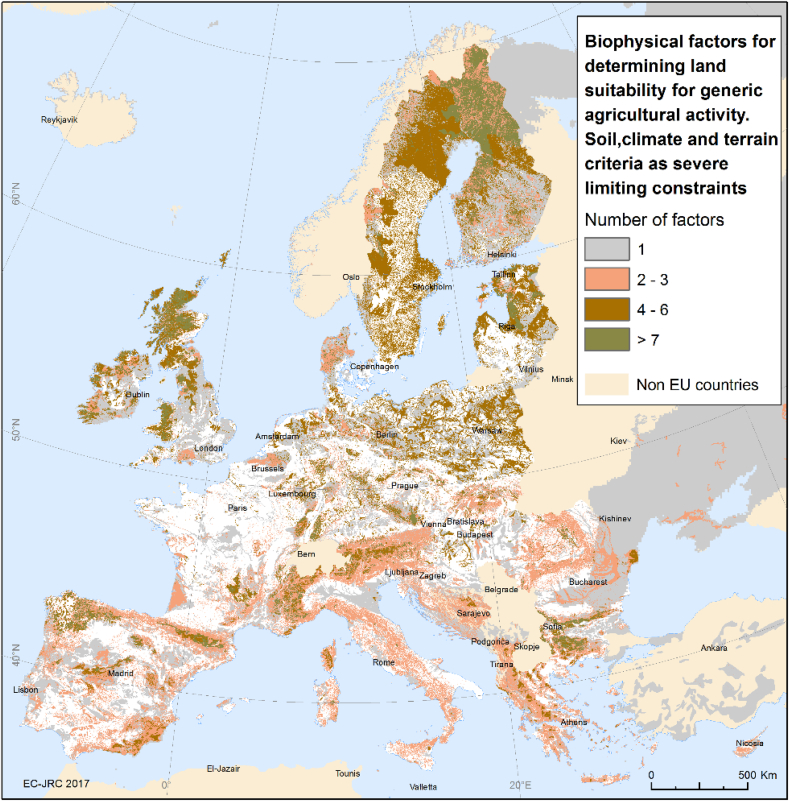
Number of biophysical factors spatially concurring for classifying land suitability for agricultural generic activities in the EU countries and the UK.